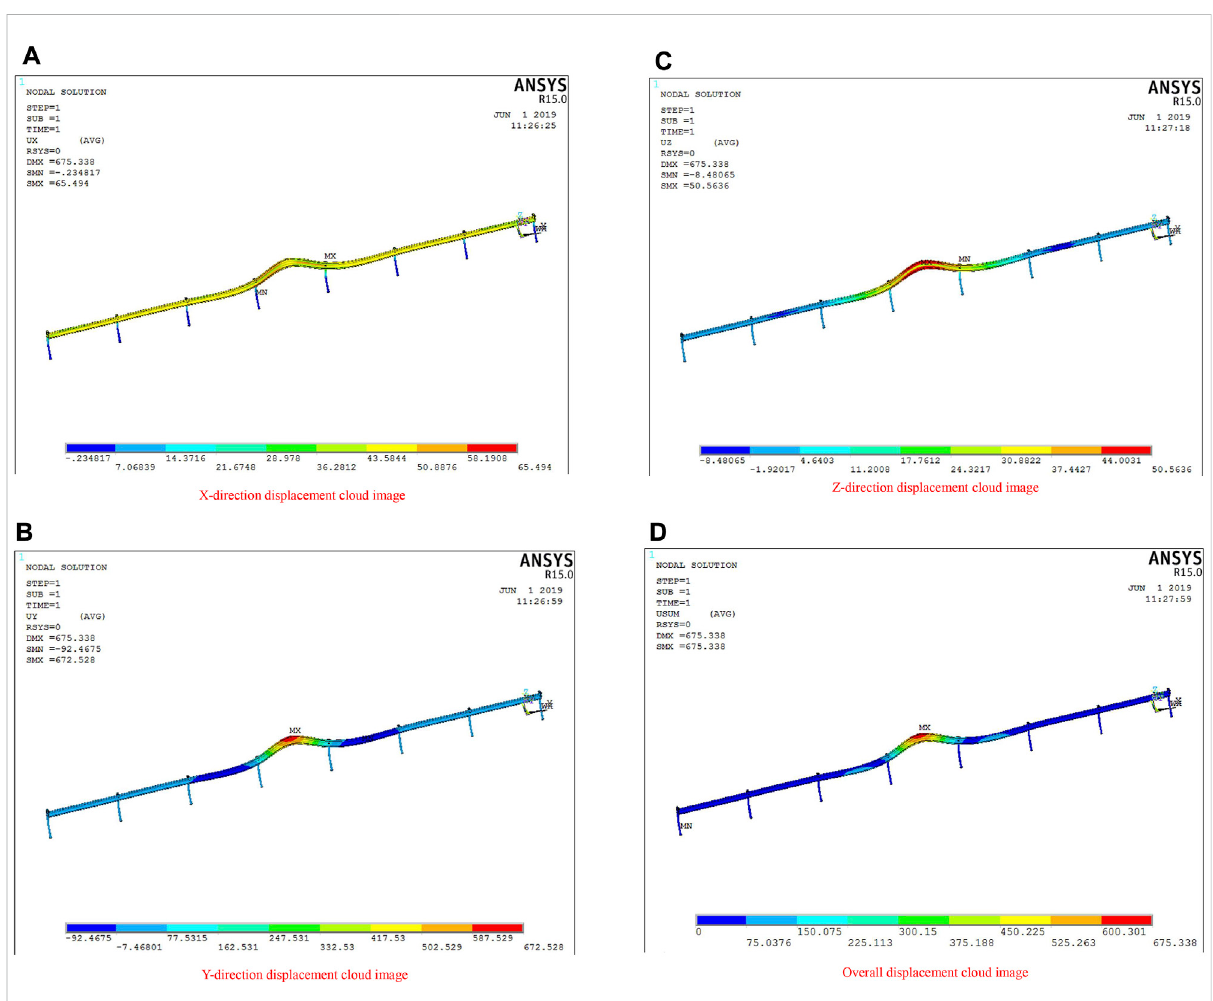
FIGURE 12 Displacementclouddiagramofathree-wavebeamsteelguardrail(impactedbythe55-tHGVatthespeedof65 km/hfromanangleof20 ° ,the soil-embedded guardrail post). (A) :Displacement cloud diagram of three-wave beam steel guardrail in Xdirection. (B) :Displacement cloud diagram ofthree-wavebeamsteelguardrailinYdirection. (C) :Displacementclouddiagramofthree-wavebeamsteelguardrailinZdirection. (D) :Theoverall displacement cloud diagram of the three-wave beam steel